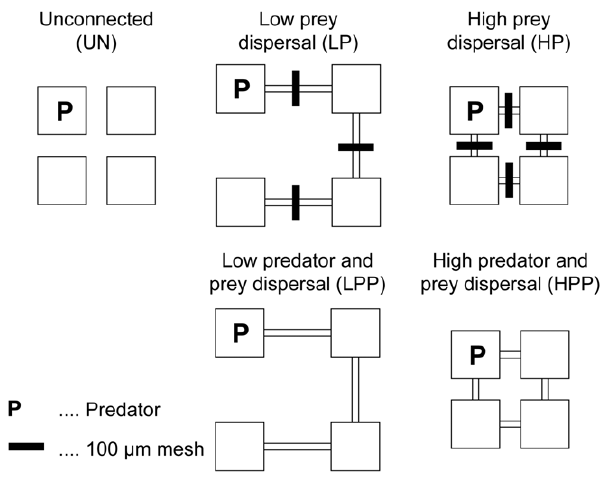
Figure 1. Experimental design of the metacommunity exper- iment and initial distribution of the predator. Four microcosms were connected according to one of three connectivity levels. Microcosms either remained unconnected (UN), were connected to an open square by tubing of 15 cm length (LP, LPP), or were connected to a closed square by tubing of 5 cm length (HP, HPP). Predatory copepods were introduced into one of the four microcosms on day 7 of the experiment. Copepods were either free to disperse to neighbouring basins (LPP, HPP) or prevented from dispersing by a 100 m m mesh in the middle of the connections (LP,